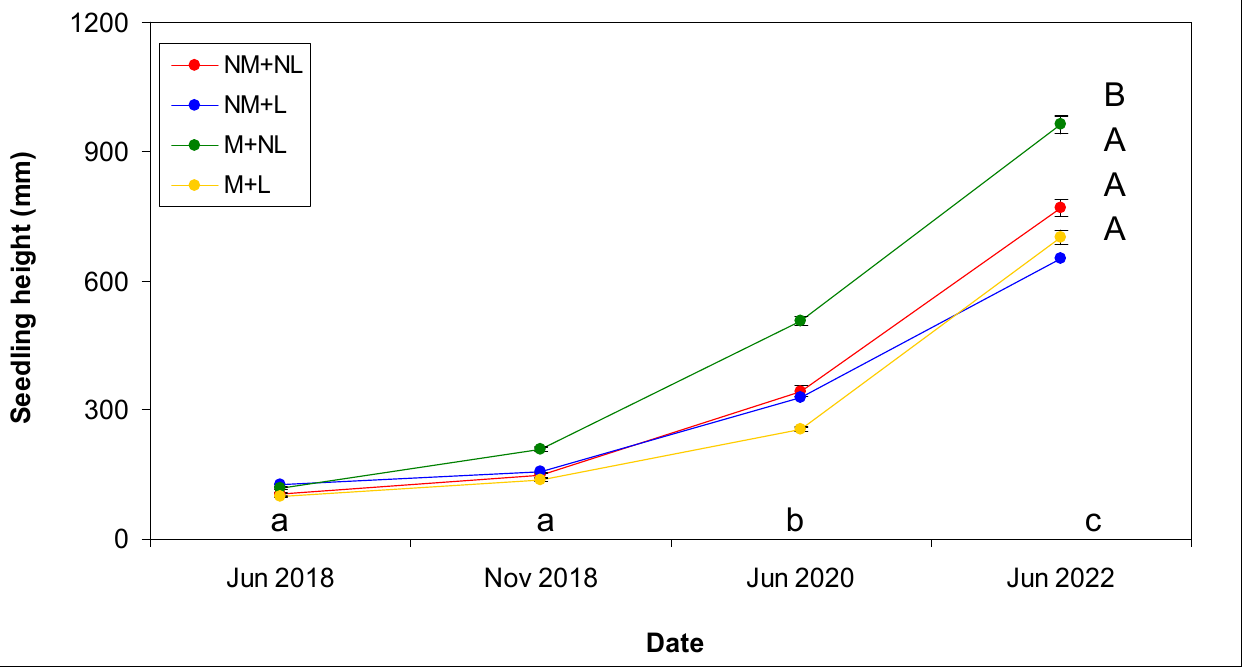
Figure 3. Variation of the height of seedlings (mean ± standard deviation) of Pinus halepensis Mill. growing in plots subjected to four treatments in Sierra de Los Donceles forest (Liétor, Castilla La Mancha, Spain). Different lowercase and capital letters indicate significant differences among survey dates and treatments, respectively, according to the LSD test ( p < 0.05). Legend: M + L = Mulching + Logging; NM + L = No Mulching + Logging; NM + NL = No Mulching + No Logging; M + NL = Mulching + No Logging.